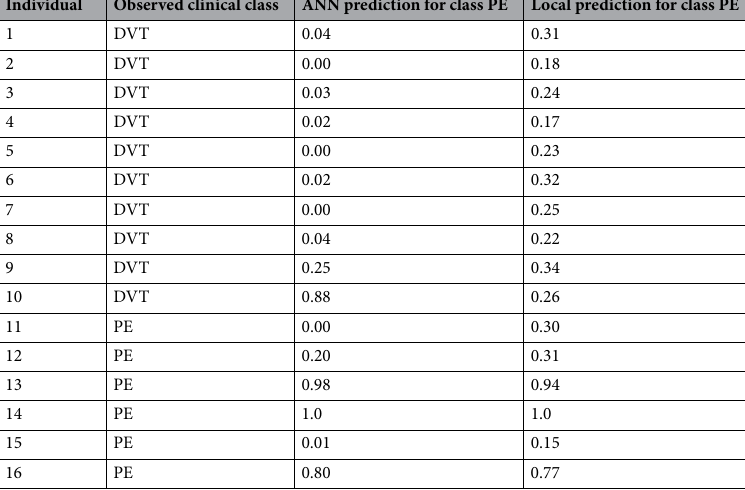
Table 2. Individual predictions of VT event provided by ANN and LIME in the 16 patients of the testing